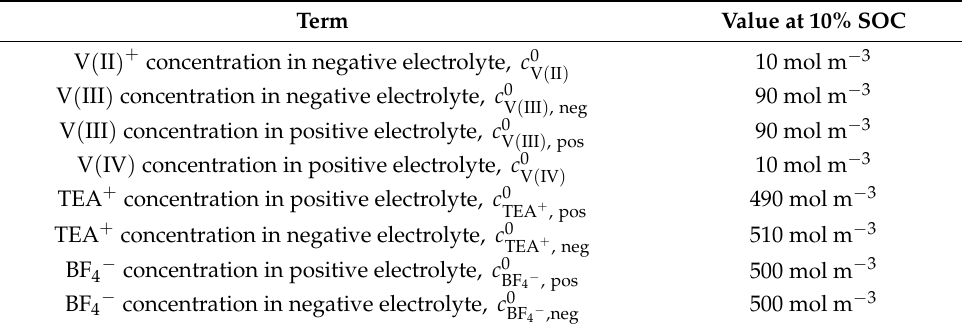
Table 5. Initial species